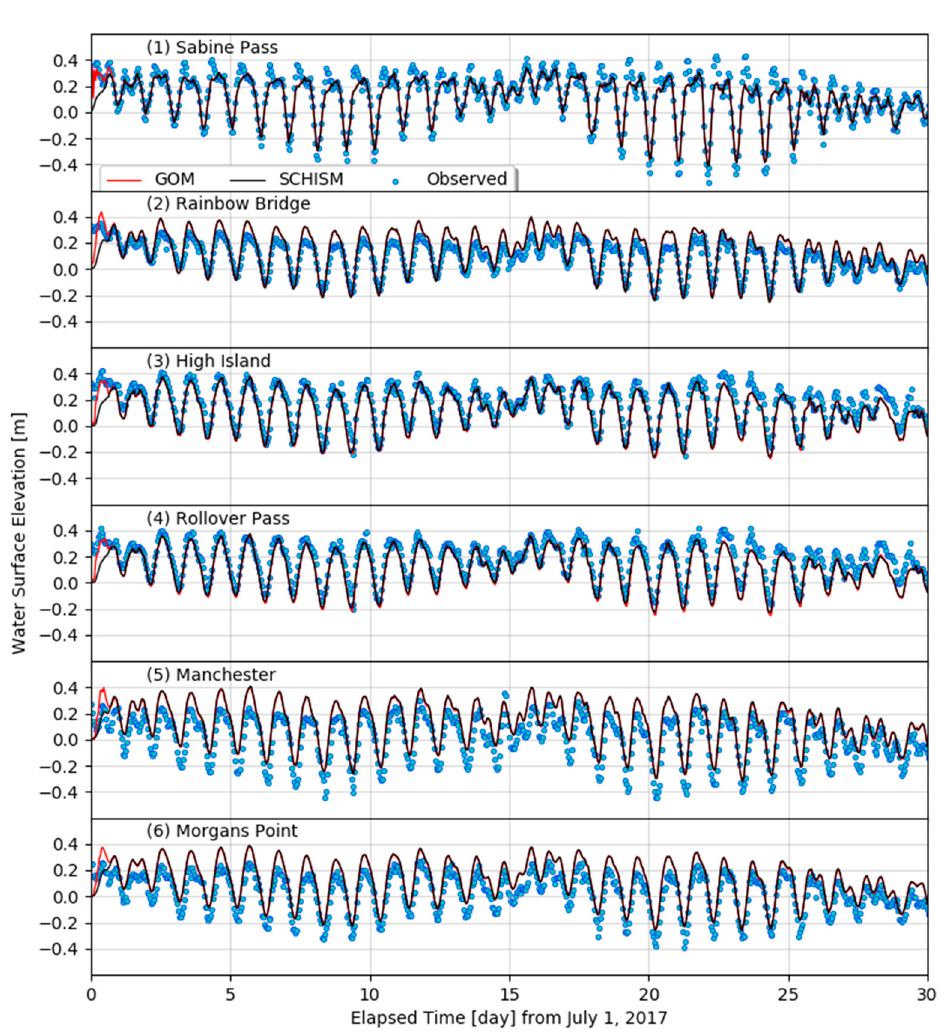
Figure 18. Water surface elevation comparison between measurements (blue circles), GOM simulation results (solid red lines), and Semi-Implicit Cross-Scale Hydroscience Integrated System Model (SCHISM) simulation results (solid black lines) from tide stations 1 to 6.